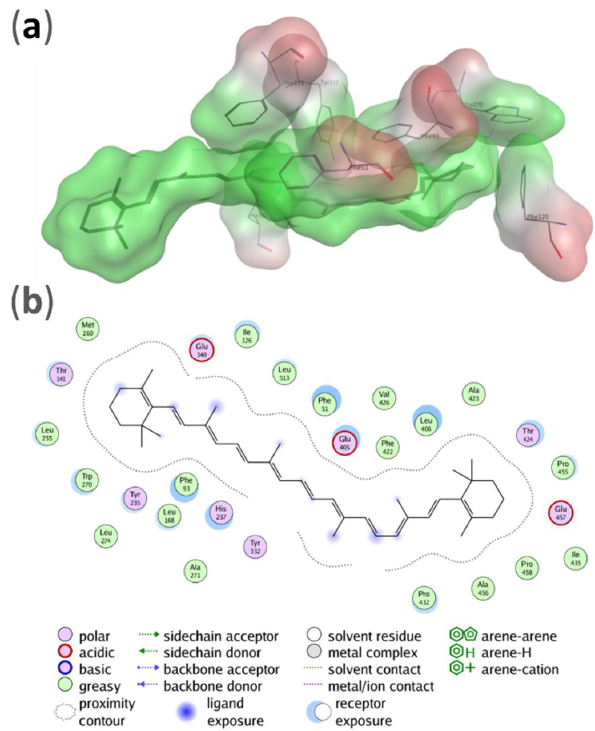
Figure 5. ( a ) Potential energy surface over the β-carotene and the BCO1 residues with which it interacts, according to PLIF analysis. The hydrophobic areas are colored in green and the hydrophilic areas in red. ( b ) Two-dimensional representation of the interactions established by β-carotene within the BCO1 catalytic site. Only the residues contacting the carotenoid at less than 4.5 Å distance are shown.